Question: In a single sentence, describe what this figure presents.
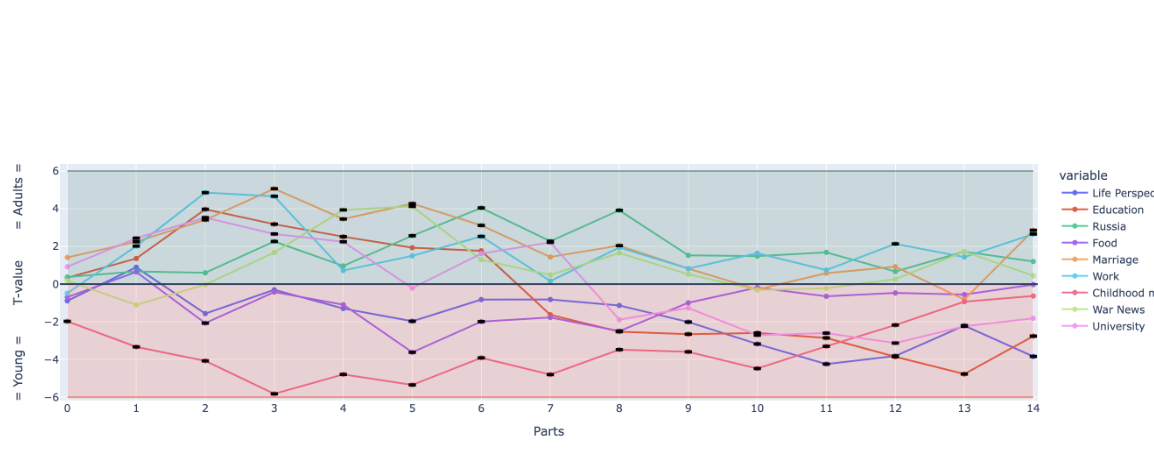
Answer: Adults vs. young survivors typical testimony t-test. The Black Point represents values with p-values under 0.01.